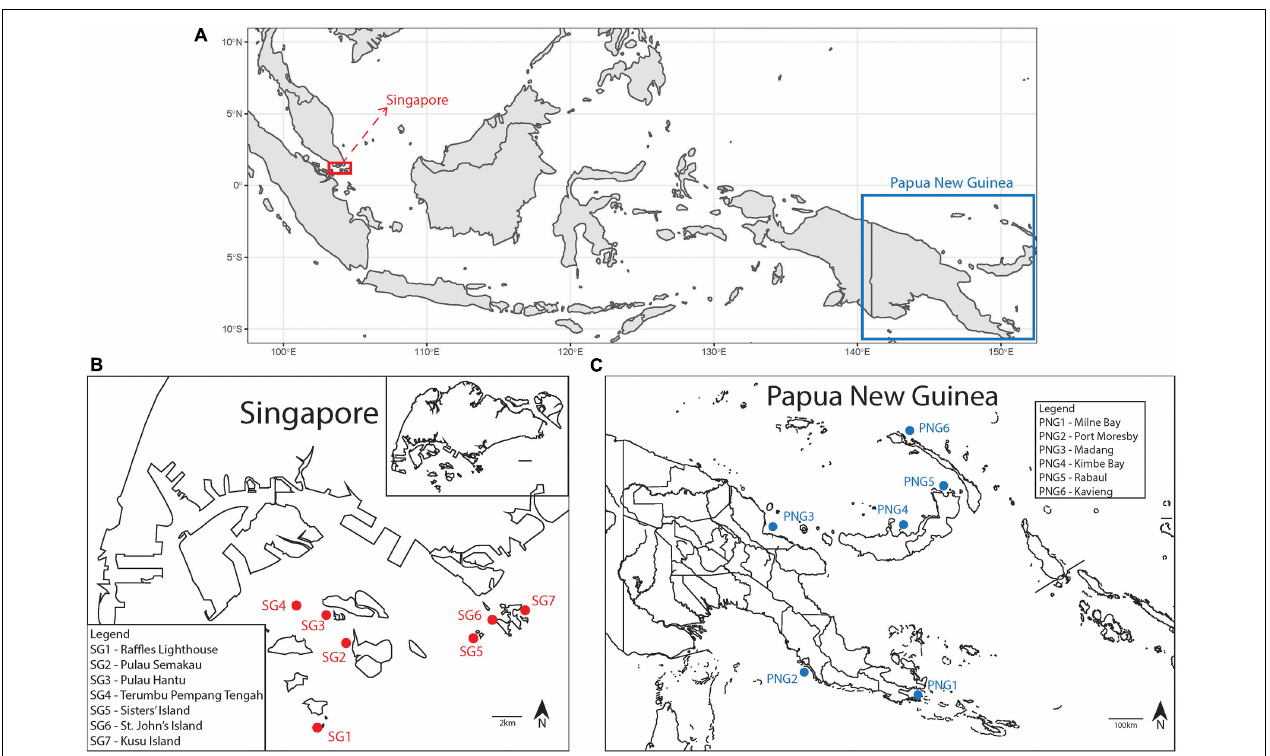
FIGURE 1 | (A) Map showing Singapore and Papua New Guinea. (B) Map of Singapore with study sites (SG1 to SG7) indicated in red (inset: Map of the entire Singapore island for reference). (C) Map of Papua New Guinea with study sites (PNG1 to PNG6) indicated in